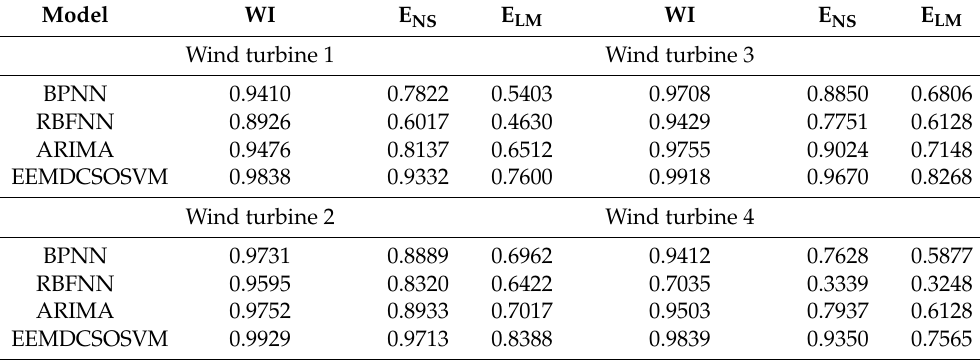
Table 5. Comparison of the value of WI, E NS and E LM between the proposed model and some traditional models (BP RBF